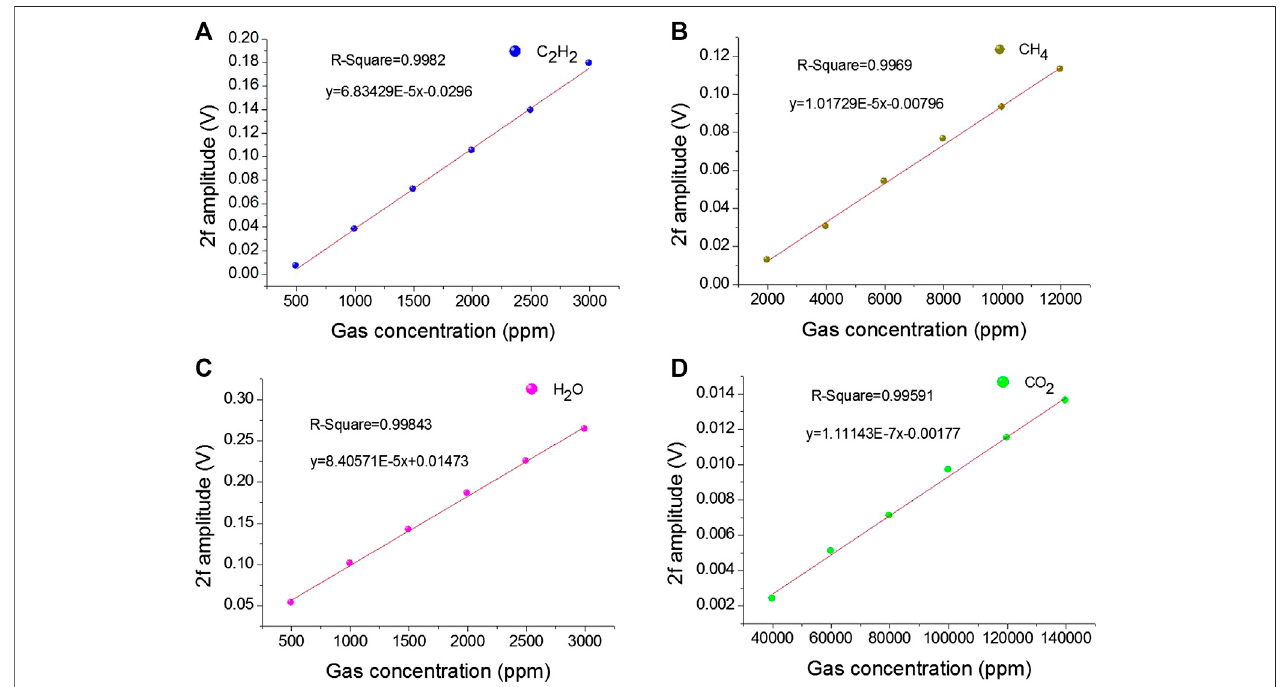
FIGURE 5 | (A) 2f PAS signals as functions of the C2H2 gas concentration. (B) 2f PAS signals as functions of the CH4 gas concentration. (C) 2f PAS signals as functions of the H2O gas concentration. (D) 2f PAS signals as functions of the CO2 gas